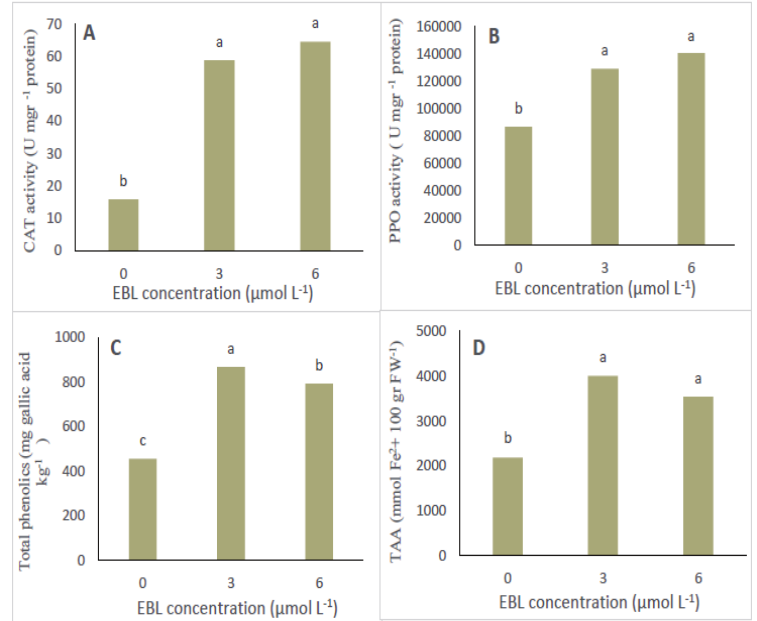
Fig. 2: Effect of EBL treatment on catalase (CAT) enzyme activity (A), polyphenoloxidase (PPO) enzyme activity (B), total phenolics content (TPC) (C) and total antioxidant activity (TAA) (D) in ‘Thompson seedless’ table grape. Different lowercase letters indicate the significance difference between the means (r=5) according to Duncan’s Multiple Range Test